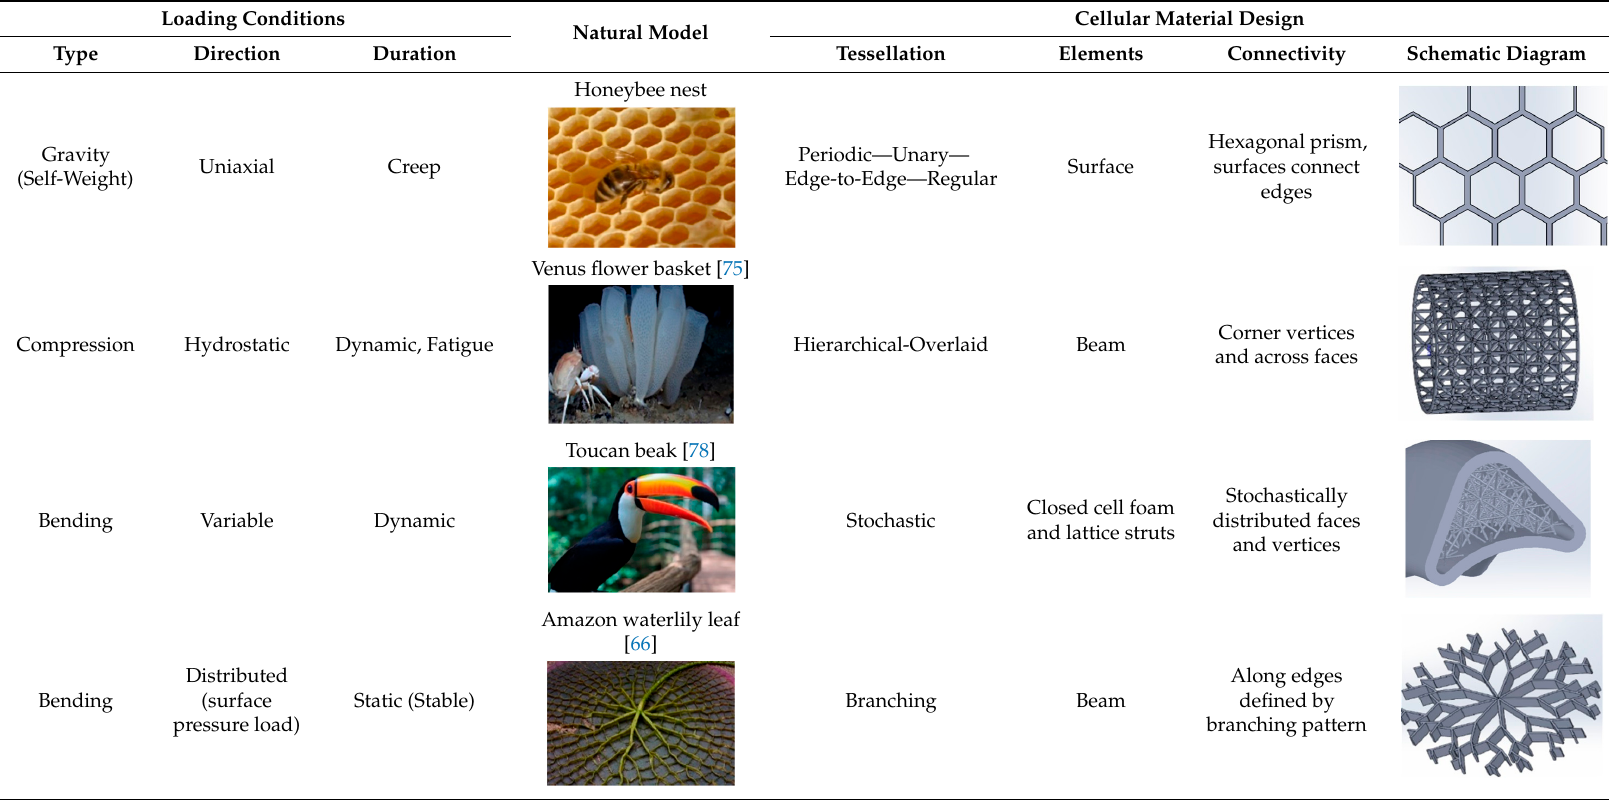
Table 5. Biomimetic cellular materials design classification levels by loading conditions.